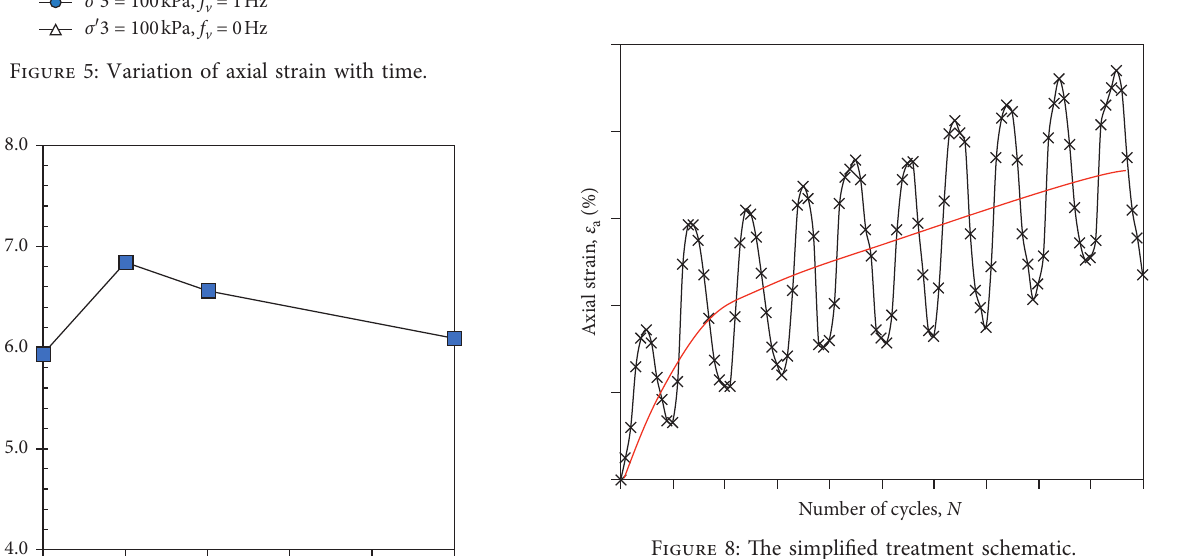
Figure 7: Variation of axial strain with the number of cycles for VDM-treated soil specimens at f c � 1Hz.